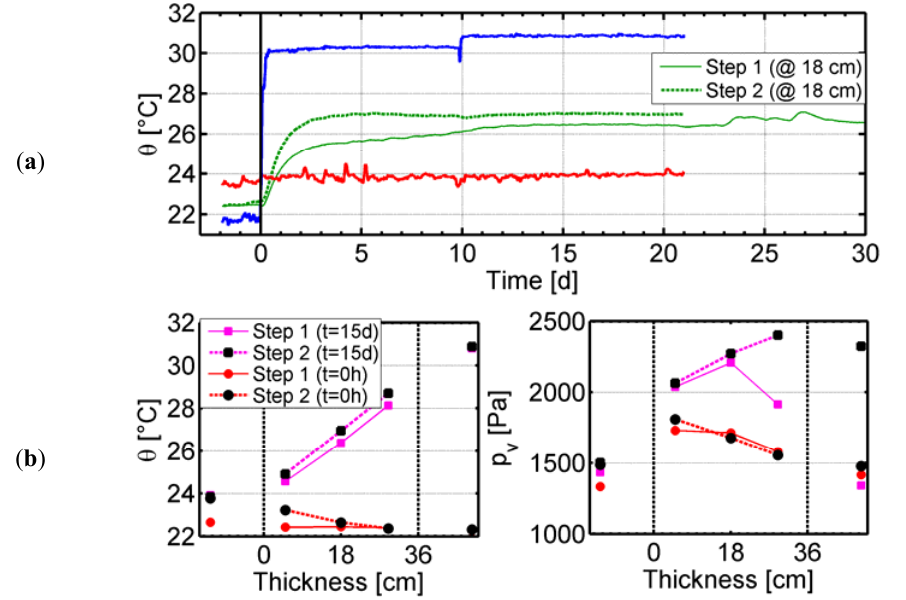
Figure 8. ( a ) Time response in θ at x = 18 cm; and ( b ) spatial response in θ and p t = 0 and 15 d of uncoated hemp concrete wall subjected to Experiment 1 (solid lines) and Experiment 2 (dashed